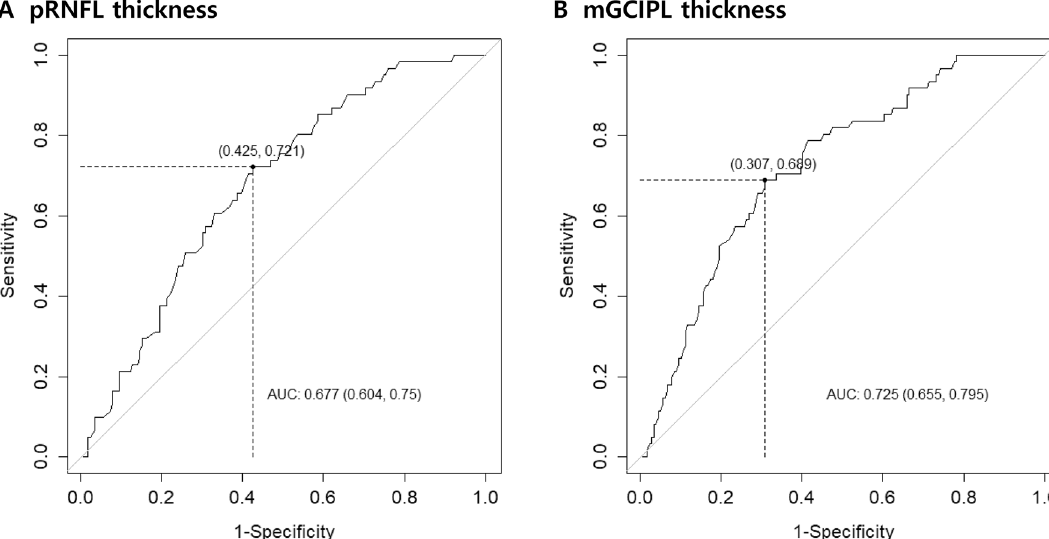
Figure 1. Receiver operating characteristics curves based on the analysis of ( A ) peripapillary retinal nerve fiber layer and ( B ) macular ganglion cell-inner plexiform layer thickness, distinguishing eyes with complete visual field recovery from those with preoperative visual field defects. The sensitivity (with 95% confidence intervals) at a specificity of 95% is indicated for each